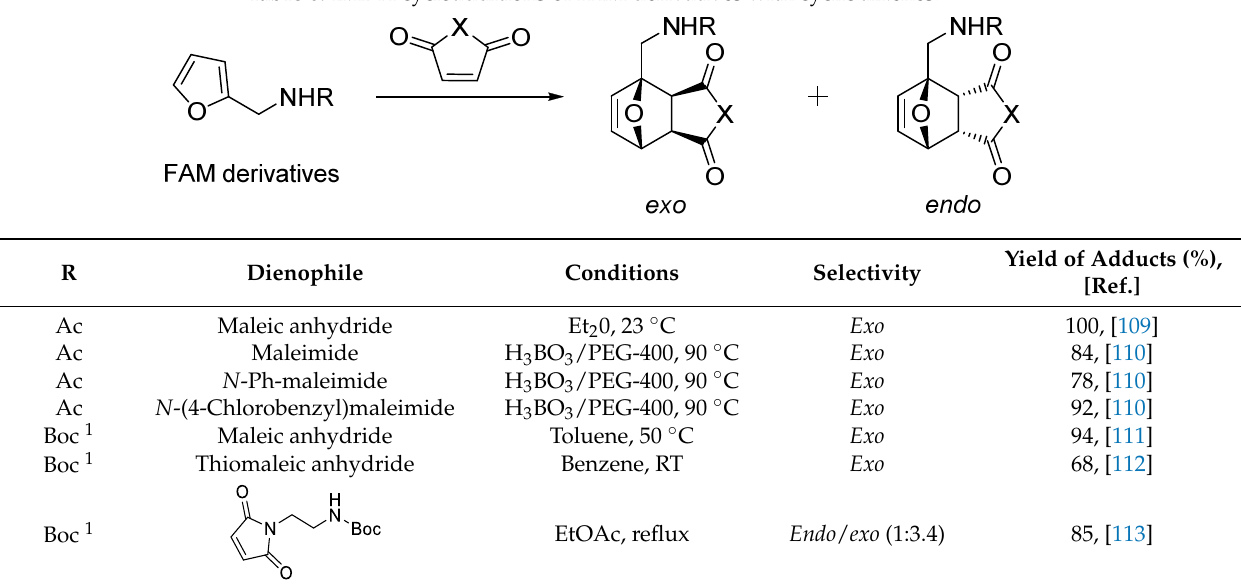
Table 6. IMDA cycloadditions of FAM derivatives with cyclic alkenes.